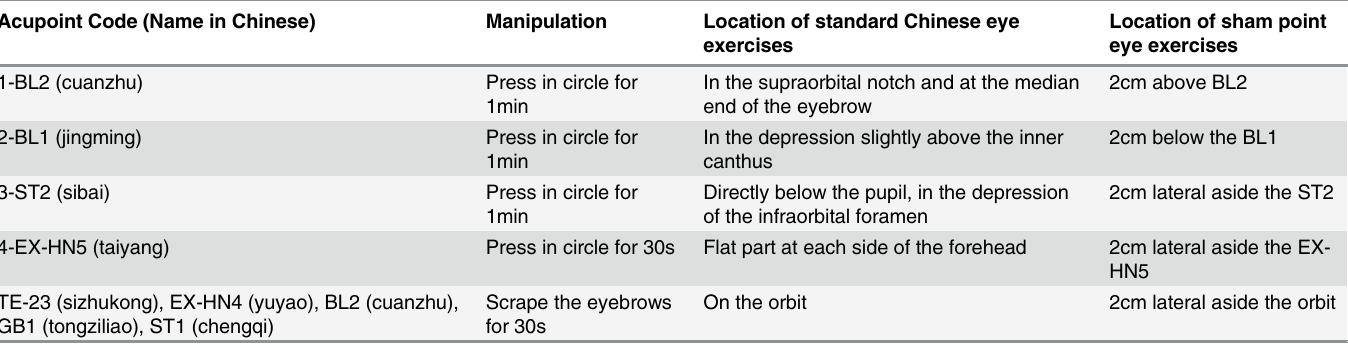
Table 1. Locations of Acupoints and Manipulation Methods Used in the Standard Chinese Eye Exercises and Sham Point Eye Exercises